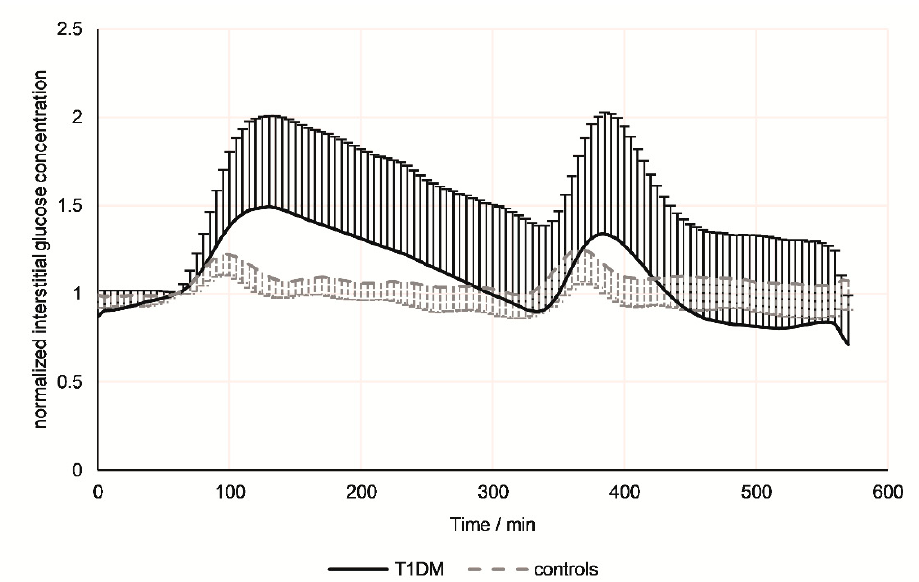
Figure 2. Time resolved glucose monitoring. Continuous glucose monitoring in healthy controls (empty squares; n = 22) and pediatric T1DM patients (full dots; n = 21) over the course of nine hours. Red lines indicate the intake of standardized meals (breakfast and lunch). Data was normalized to minute 60 (baseline before breakfast) to emphasize relative changes and minimize inter-individual variation. Table 2. Time resolved analysis of the changes in serum concentrations. Per group and parameter, data for median is given, and significant changes (repeated measurement ANOVA on ranks in combination with Dunn’s method for pair-wise multiple comparisons versus control), are marked in bold and with an asterisk or hash, respectively. Significant changes in the first half of the experiment versus baseline (min 60, immediately before breakfast) is marked with an asterisk (*) and significant changes in the second half of the experiment versus minute 330 (immediately before lunch) are marked with a hash (#). P -values of 0.05 or lower were considered as significant.